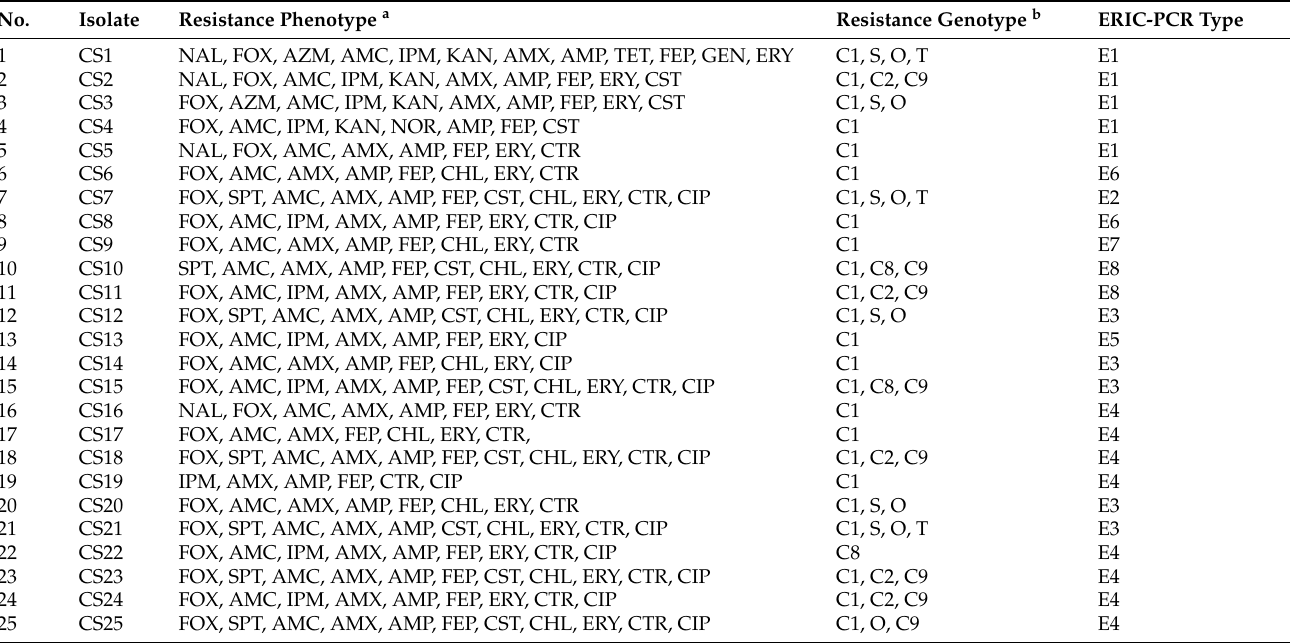
Table 2. Resistance phenotype, genotype and ERIC-PCR types in C. sakazakii strains isolated from PIFM